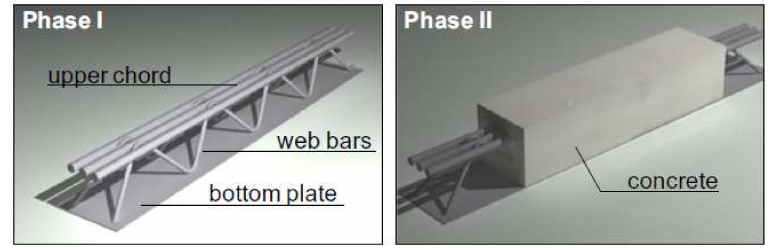
Figure 3. Beam structural schemes in operating Phases I and